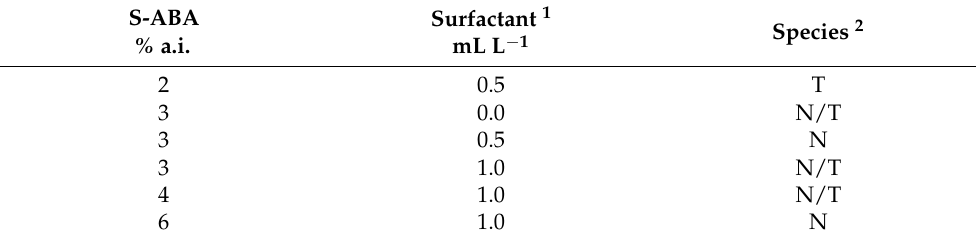
Surfactant 1 mL L − 1